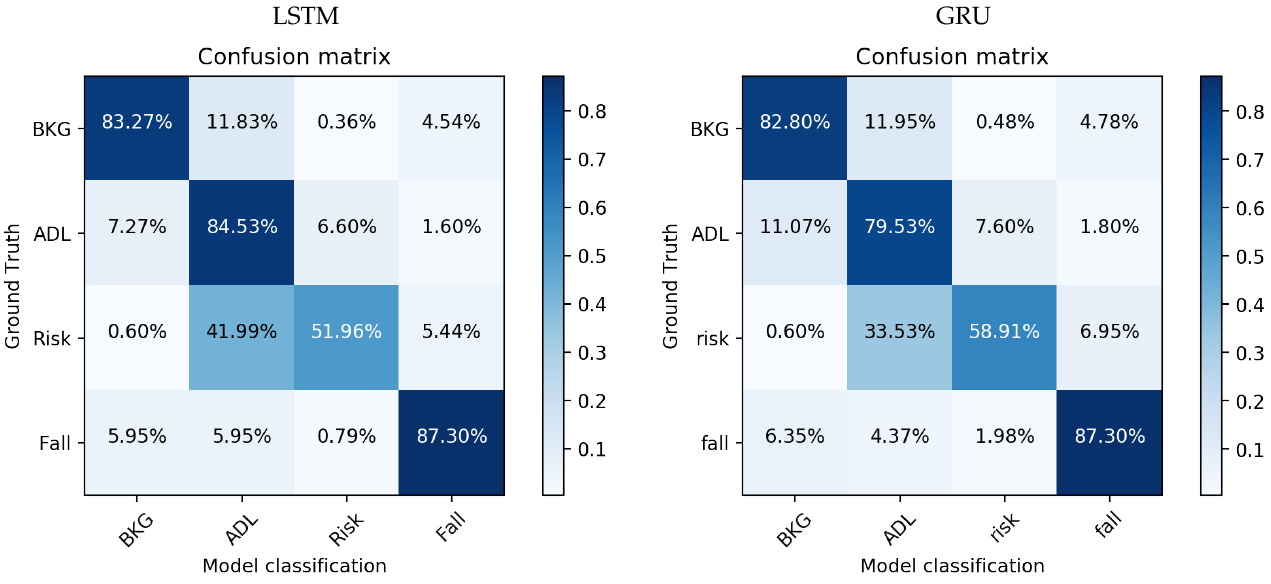
Figure 8. Confusion matrices for best LSTM and GRU models. Each specific box in the confusion matrix represents the percentage of samples of the class indicated by the row that have been classified as the class indicated in the